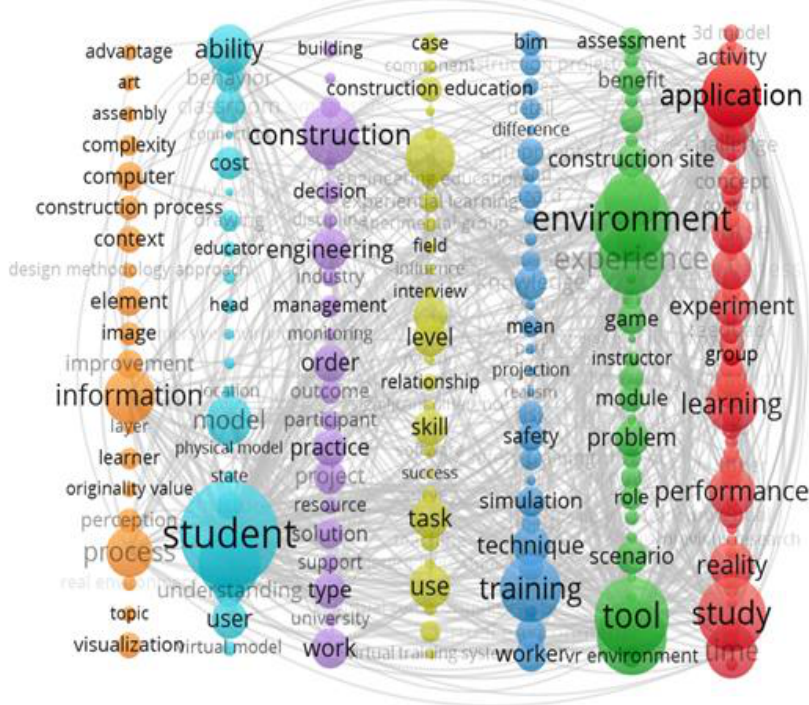
Figure 6. Mapping on network visualization of abstract field co-occurrence in education and training.